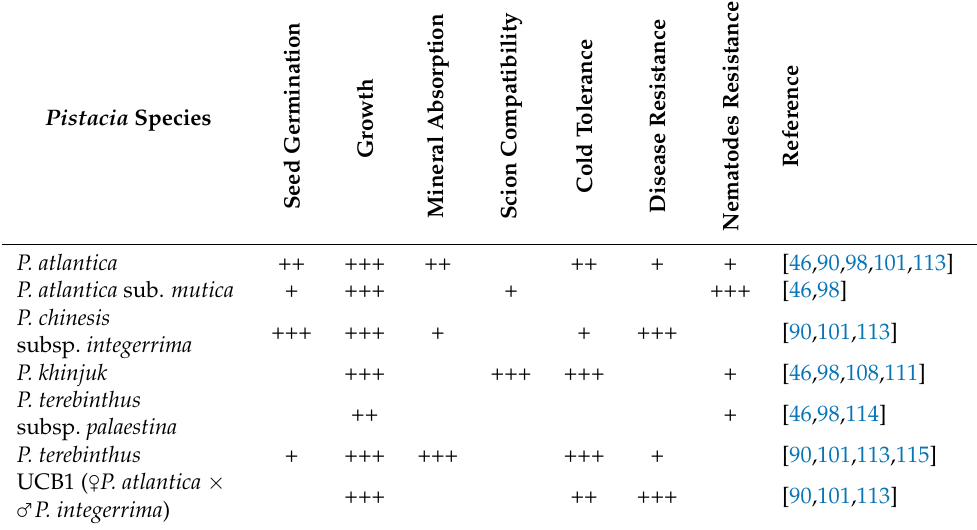
Table 2. Physiological main characteristics of most important pistachio